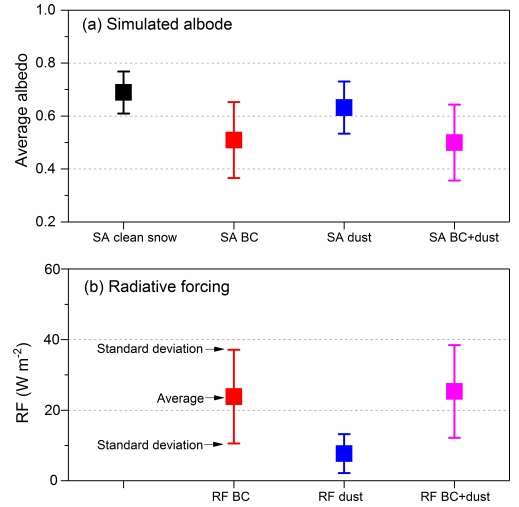
Figure 7. (a) Average albedo (solid rectangles) of snow cover due to aging only and impurities relative to the clean snow and (b) result- ing clear sky instantaneous radiative forcing (solid rectangle means the average). Note: SA means simulated albedo, SA BC means albedo only with BC in snow, SA dust means albedo only with dust in snow, and SA BC + dust means albedo with BC and dust in snow. RF means radiative forcing, RF BC means the RF caused by BC in snow, RF dust means the RF caused by dust in snow, and RF BC + dust means the RF caused by BC and dust in snow. The solid rectangles are the central average estimate, whereas the bars show the SD range of albedo and